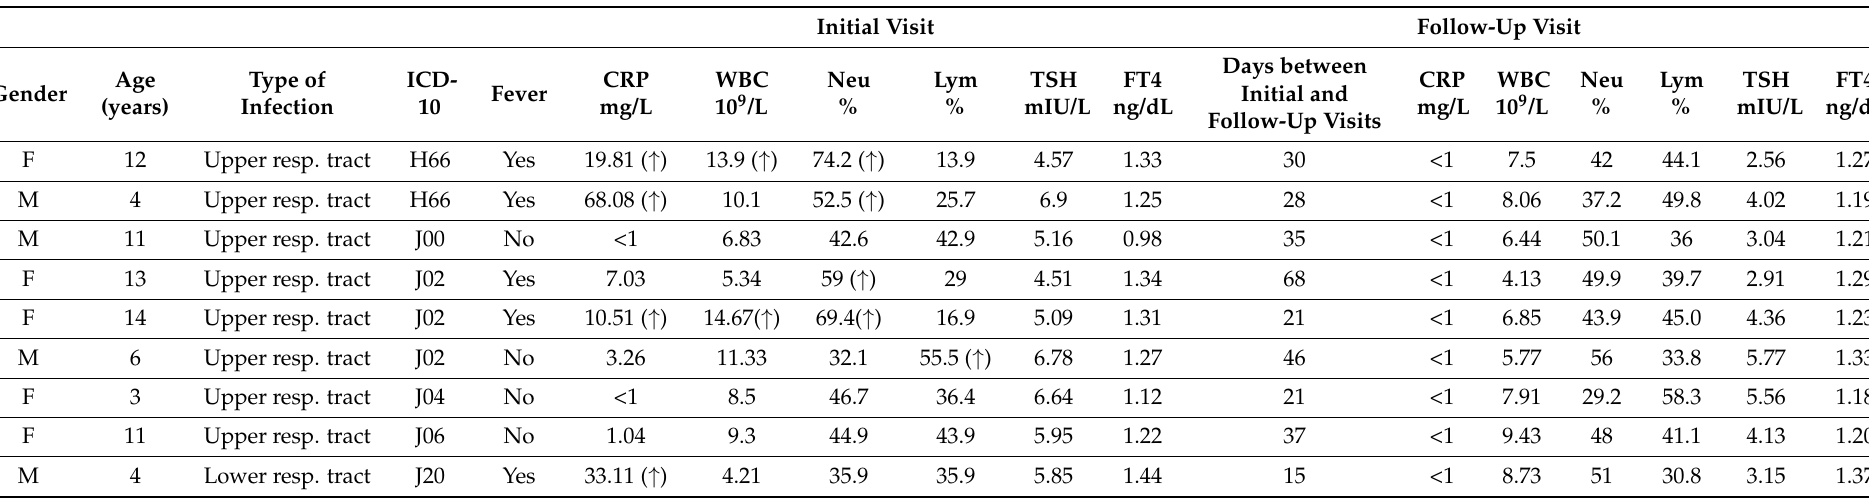
Table 2. A detailed analysis of the cases where elevated thyroid stimulating hormone (TSH) was